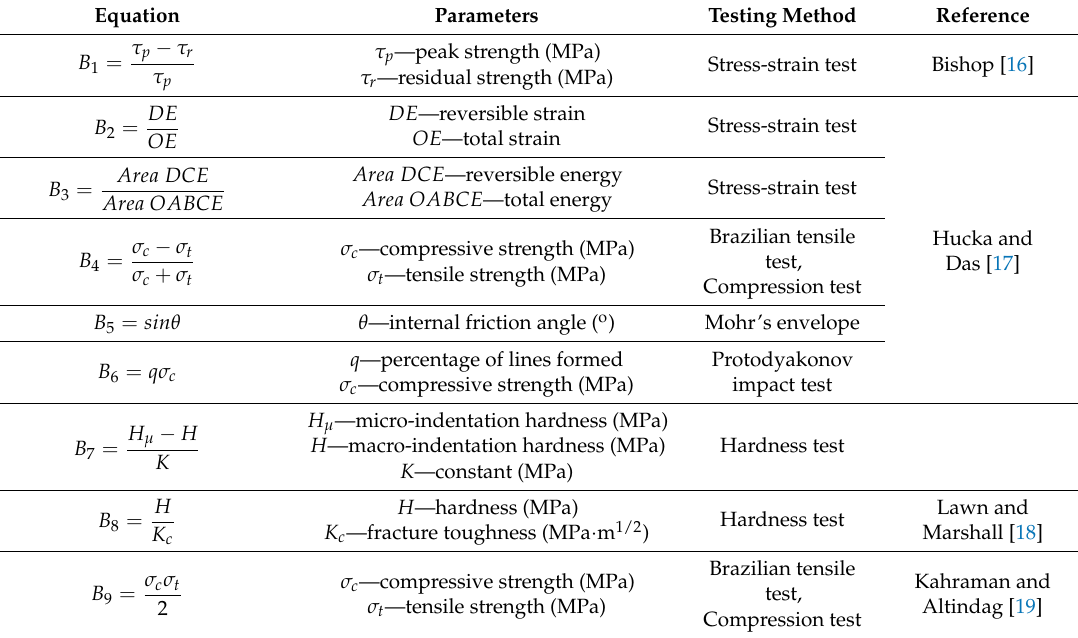
Table 1. Various BI definitions used in the